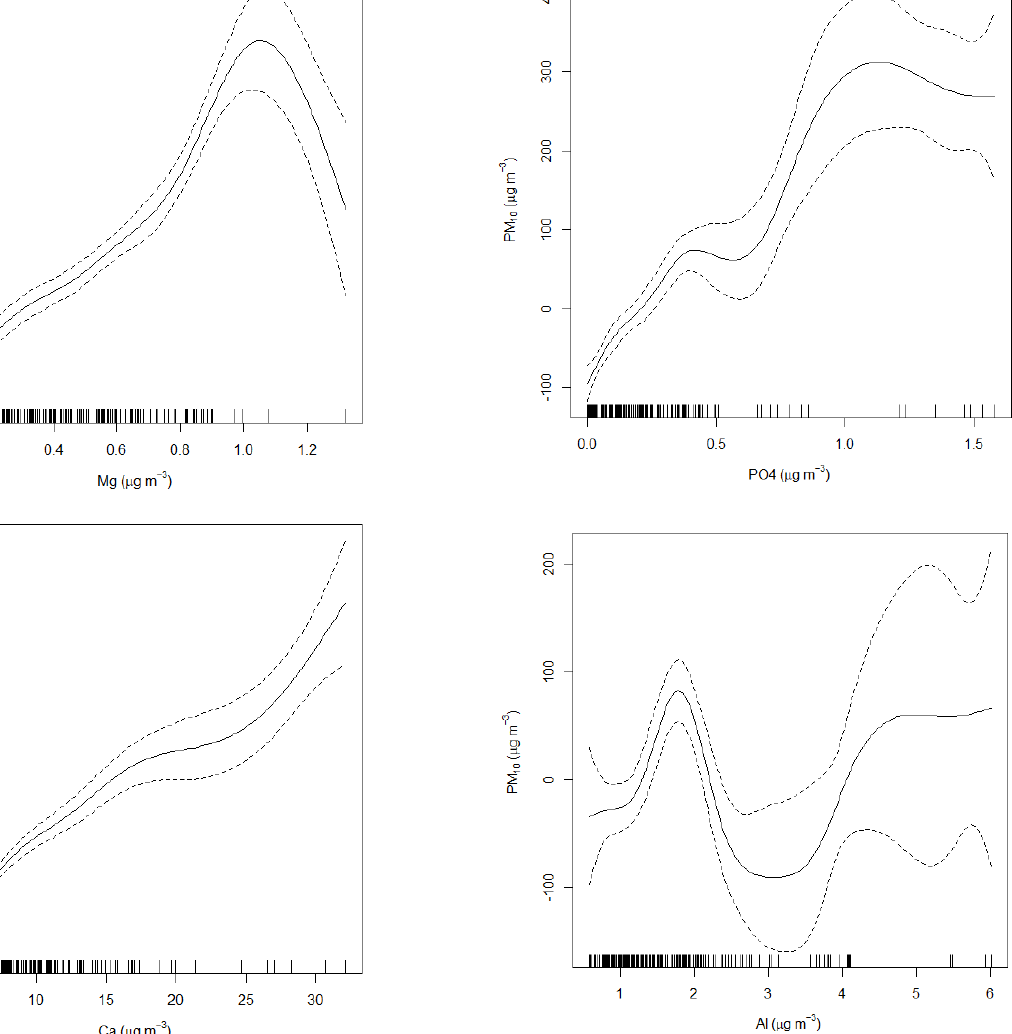
Figure 6. Showing the nonlinear association of PM 10 with the predictors (only four predictors i.e. Mg, PO 4 , Ca and Al are shown for brevity). The dashed lines show the confident intervals and the vertical lines on the x -axis show the data presence.